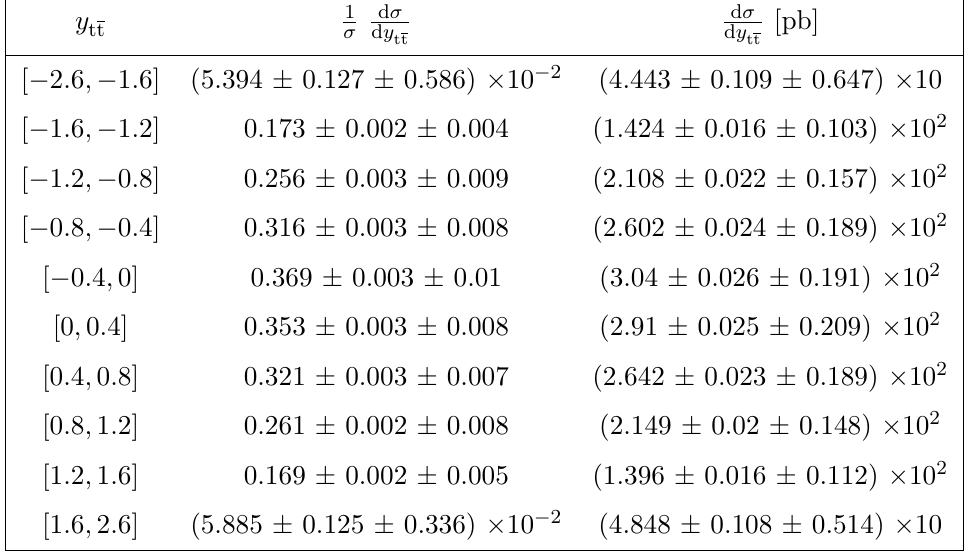
Table 11 . The measured di(cid:11)erential cross section and bin boundaries for each bin of the normalized and absolute measurements of the tt di(cid:11)erential cross section at parton level in the full phase space as a function of y are tabulated. tt